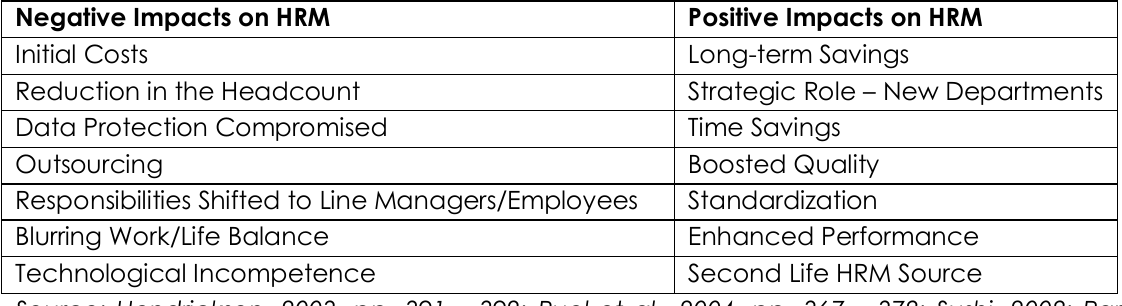
Table 1. The Impacts of the Adopted Technology on